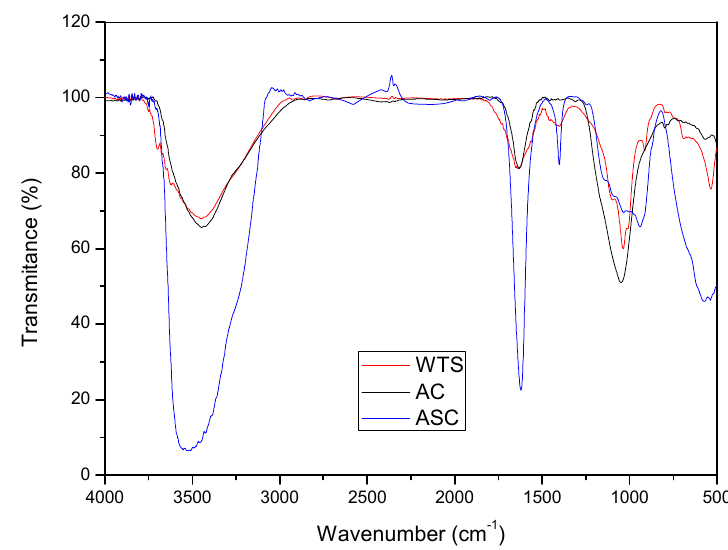
Figure 1. Fourier transform infrared spectroscopy (FT-IR) Spectrum of water treatment sludge (WTS), AC and ASC samples.